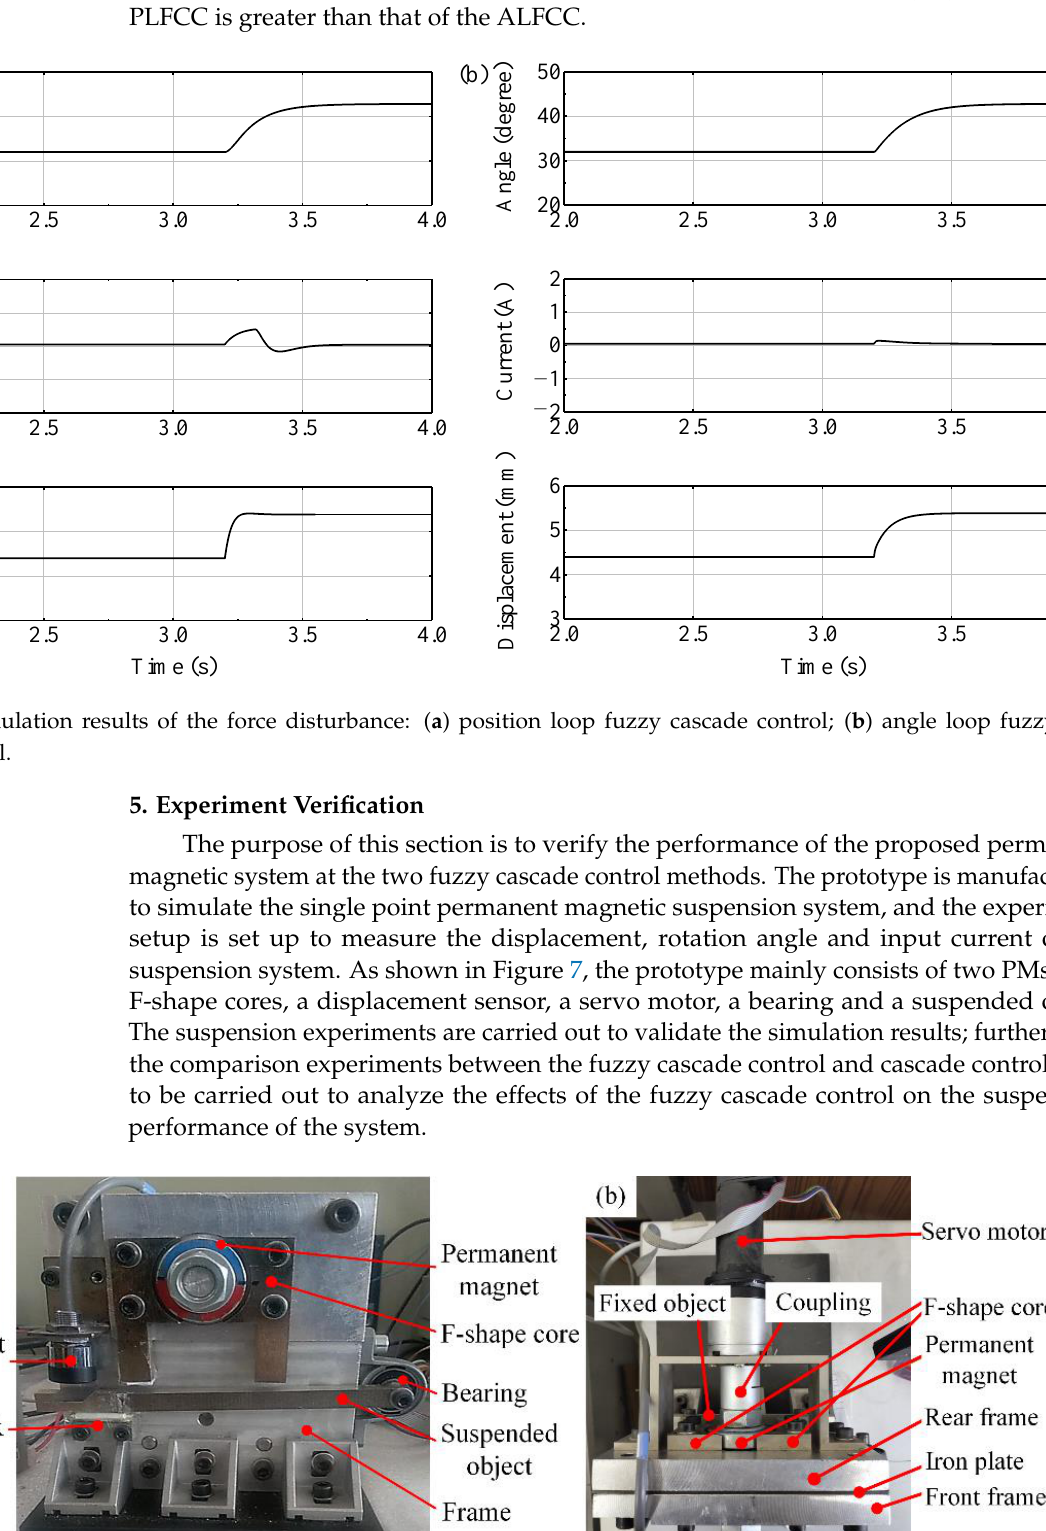
10 of 17 Figure 5. Simulation results of the displacement disturbance: ( a ) position loop fuzzy cascade control; ( b ) angle loop fuzzy cascade control.